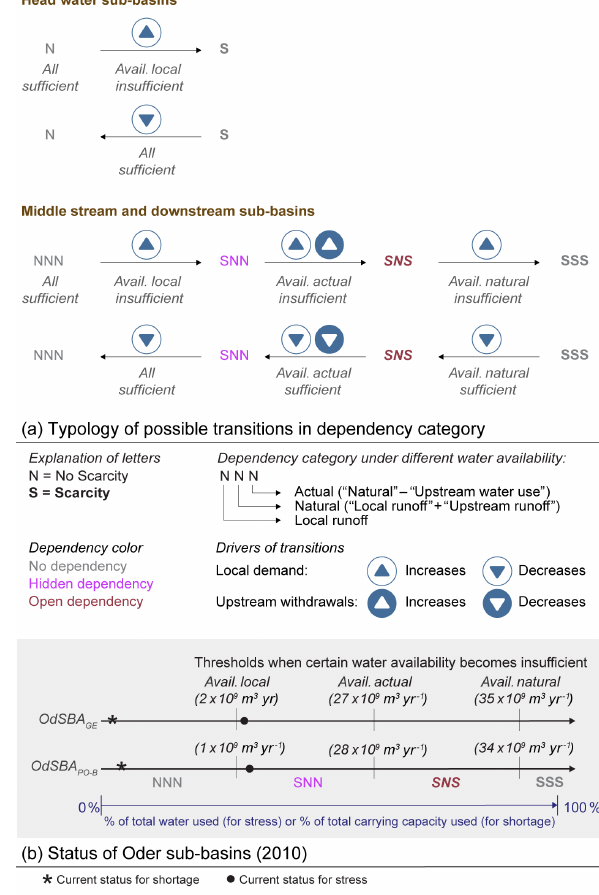
Figure 5. Typology of possible transitions in dependency category, as local water demand or upstream water withdrawals (WW) in- crease or decrease (a) . Upstream WWs decrease the downstream water availability, while local water demand increases the pressure on available resources. The current (2010) status of OdSBA GE and OdSBA PO-B (for both stress and shortage) is shown in the transition map (b) . See definitions of terminology in Table